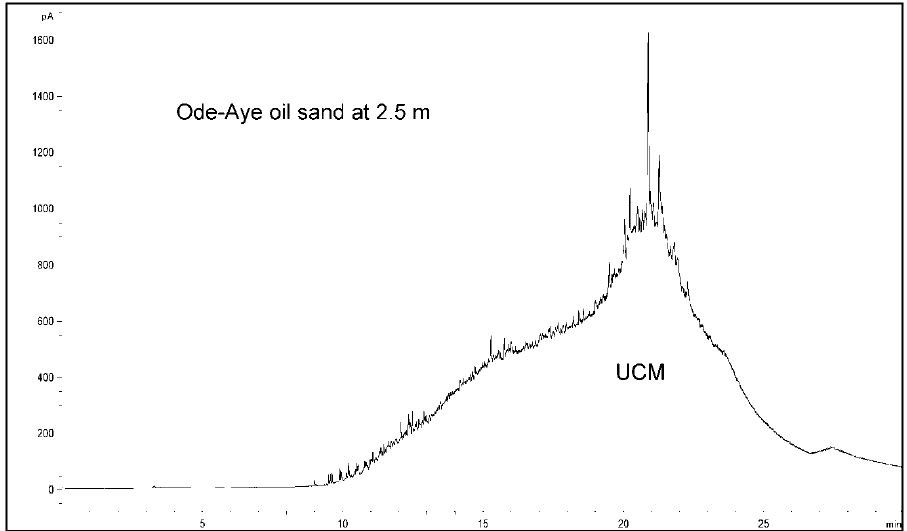
Figure 3. Chromatogram of Ode-Aye-1 oil sand at a depth of 2.5 m. The response intensity (pA) is displayed on the y -axis, while the retention time is shown on the x -axis in minutes. The chromatogram showed the hump of the unresolved complex mixture (UCM) below the peaks, suggesting biodegraded oil.